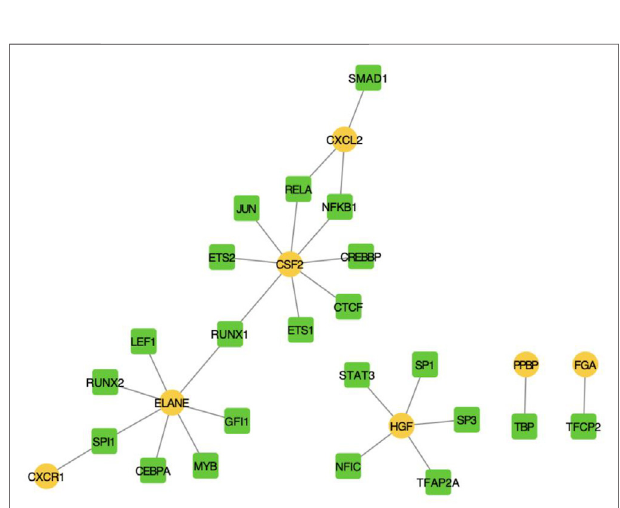
FIGURE 6 | Transcription factor-mediated regulatory